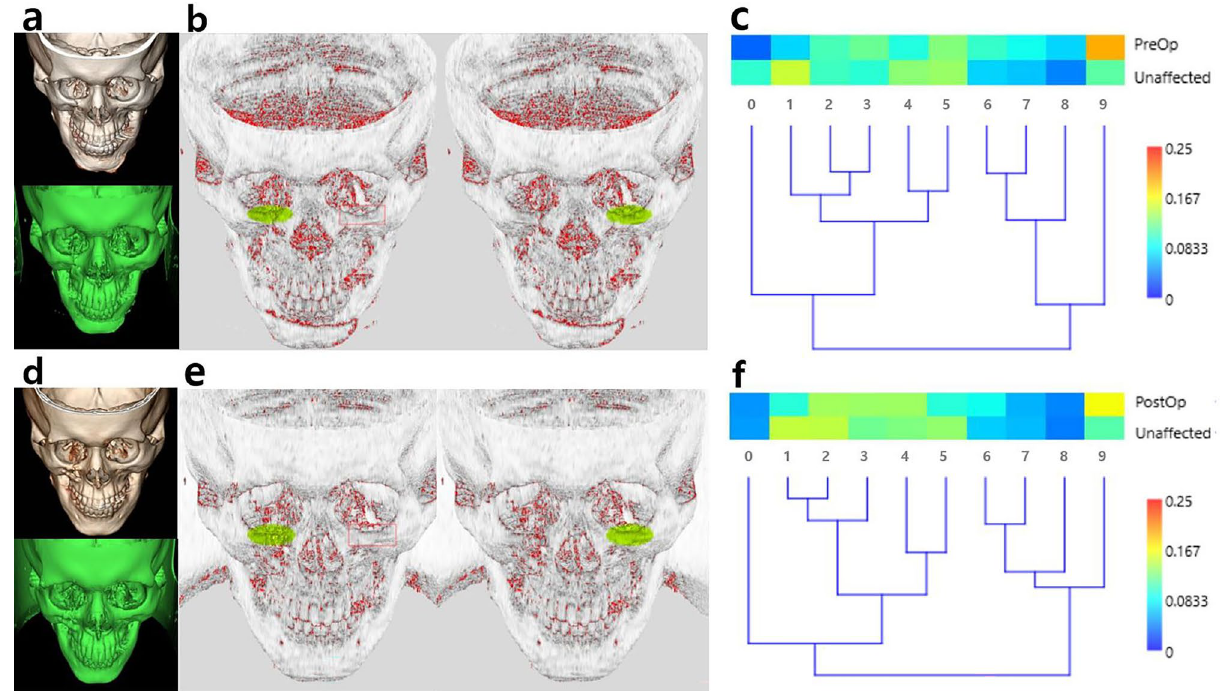
Figure 3. Similarity analysis of the inferior orbital rim using BCSI and hierarchical clustering. ( a ) Fractured right inferior orbital rim was presented in DICOM and OBJ images. ( b ) The subject areas on affected and unaffected sides were selected and displayed in fluorescent green. ( c ) The BCSI was 0.81, and the discrepancy between both sides showed notable components using the red–yellow–green–blue color spectrum chart. ( d ) The fracture site was reduced postoperatively. ( e ) The subject areas were selected in postoperative images. ( f ) The postoperative BCSI was 0.9 showing increment compared to the preoperative value, 0.81. The differences were improved in comparison with the preoperative